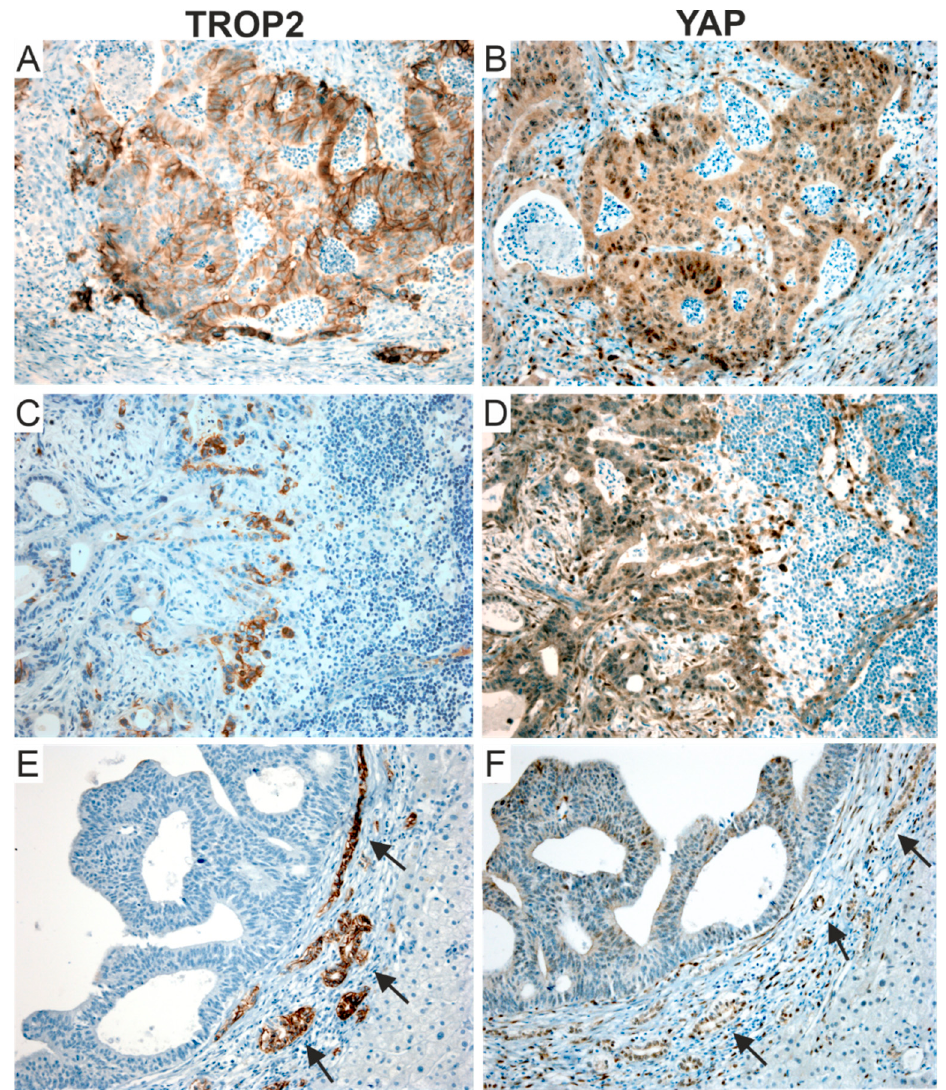
Figure 9. Immunohistochemical detection of TROP2 and YAP in CRCs shows considerable hetero- geneity, with YAP showing stronger expression. Serial sections of primary CRC ( A , B ) and lymph node ( C , D ) and liver metastases ( E , F ) were stained for TROP2 and YAP. Positive staining of intrahepatic cholangiocytes (black arrows in E , F ) was used as an internal control; original magnification 200×.